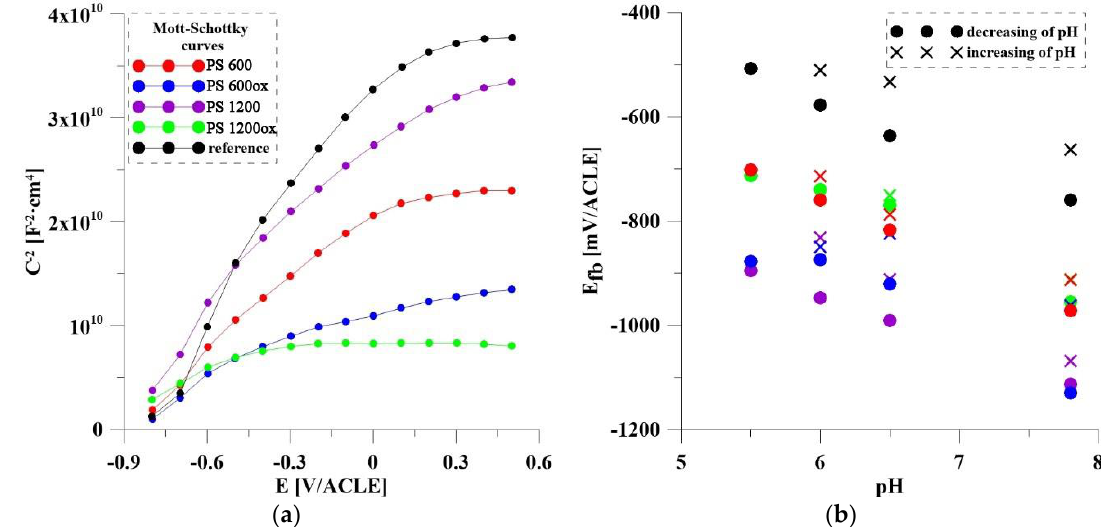
Figure 8. ( a ) Mott – Schottky curves of all samples; ( b ) dependence of E fb on pH. Table 5. Results of modelling the impedance spectra for all samples .